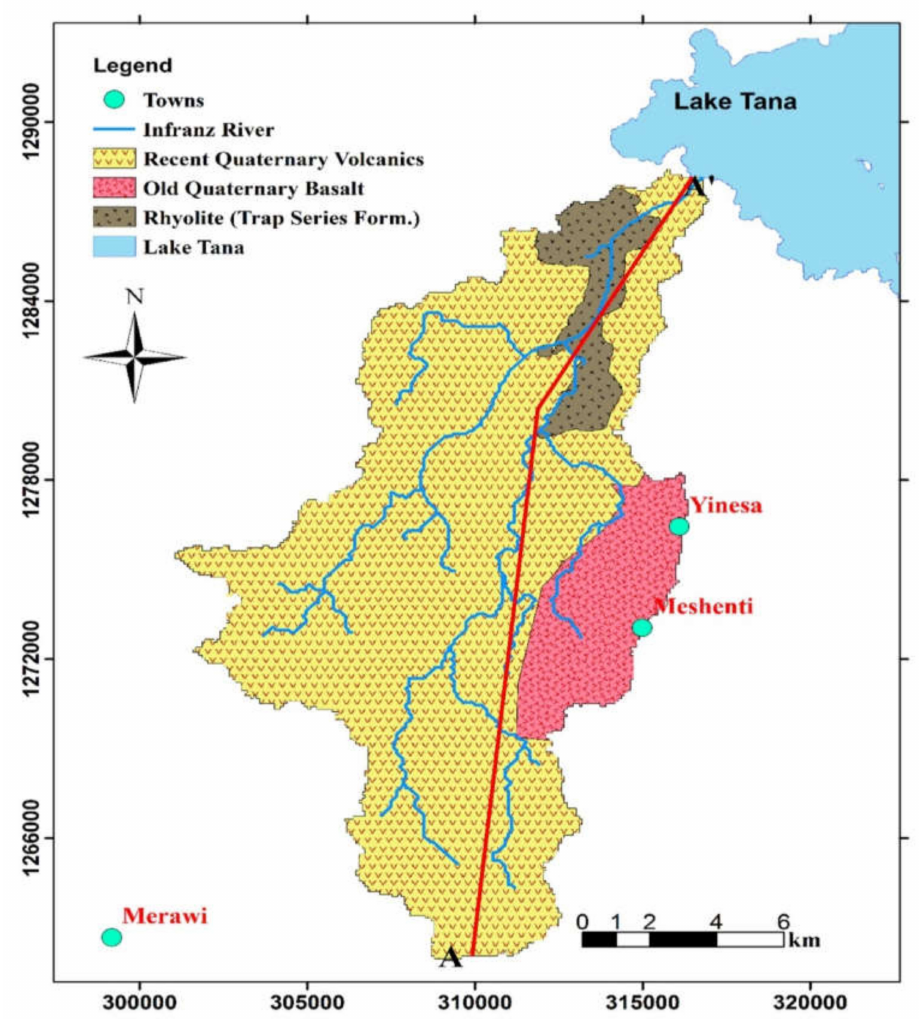
Figure 2. Geological map of the Infranz catchment and location of the cross-section (the red line passes through A-A’ is showing a cross-section line).